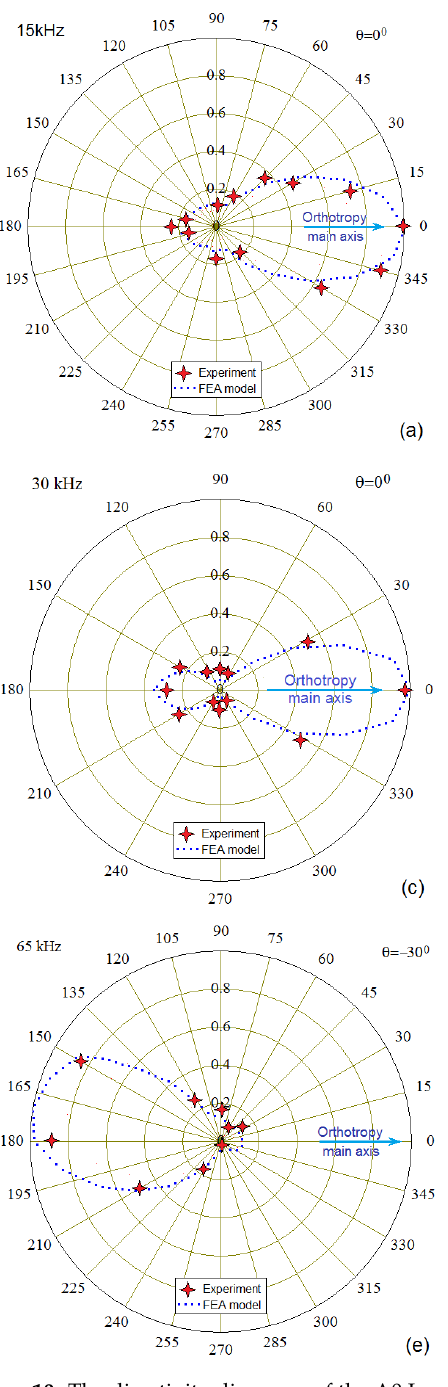
Figure 10. The directivity diagrams of the A0 Lamb waves propagating at the different wedge actuator orientation for the excitation frequencies 15 kHz ( a , b ), 30 kHz ( c , d ), and 65 kHz ( e , f ).